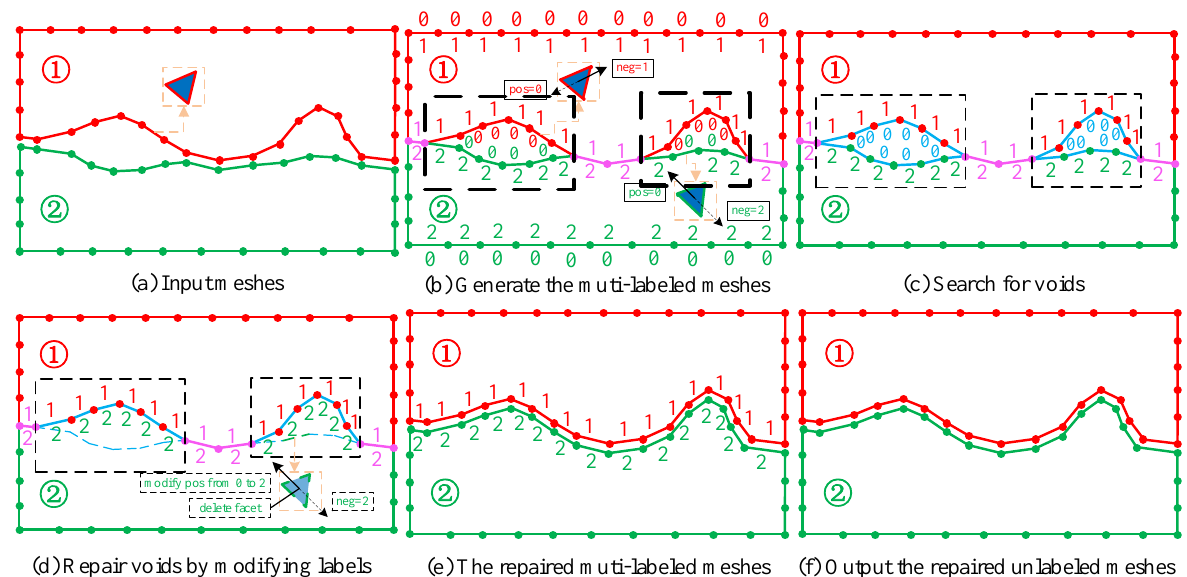
Figure 2. Overall flow chart of the method: ( a ) input meshes; ( b ) generate the muti-labeled meshes; ( c ) search for voids; ( d ) repair voids by modifying labels; ( e ) the repaired muti-labeled meshes; ( f ) output the repaired unlabeled meshes. The black boxes in ( b ) point to the voids between the input meshes, and the purple parts are overlapping regions.